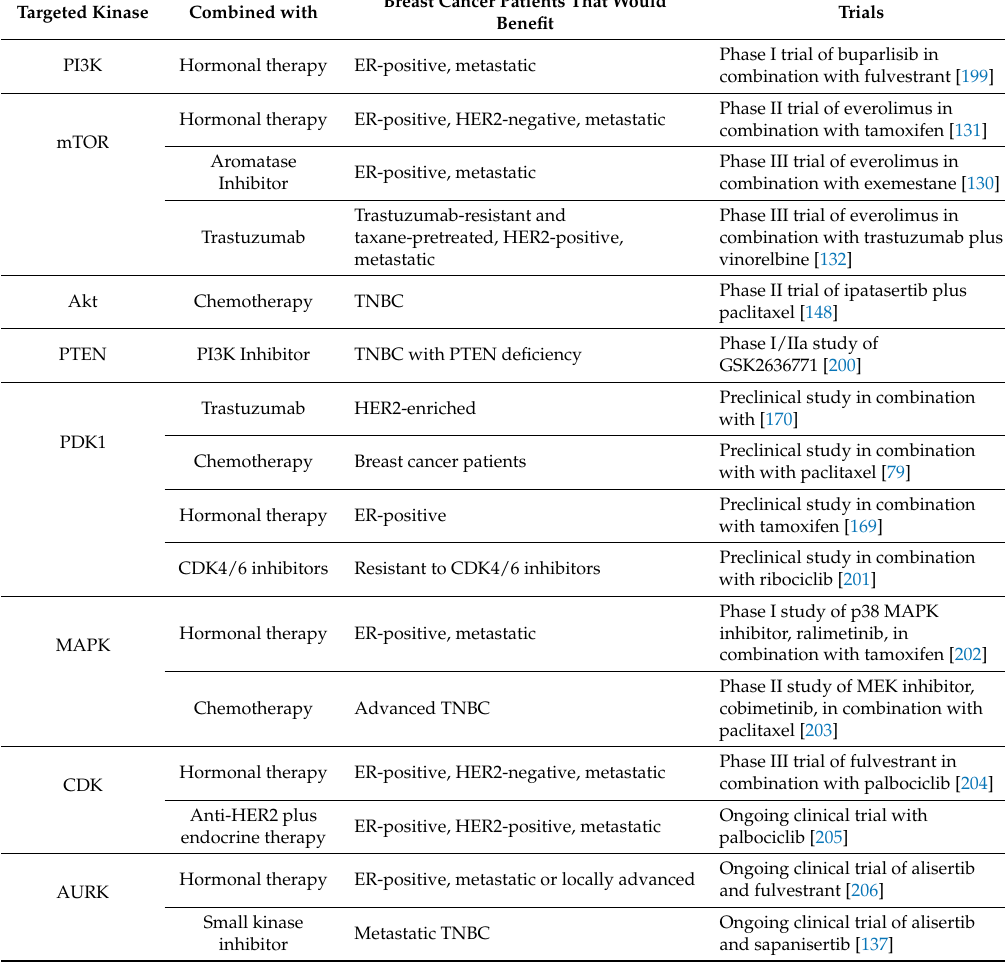
Table 16. Combination therapy strategy with protein kinases for breast cancer treatment. Targeted Kinase Combined